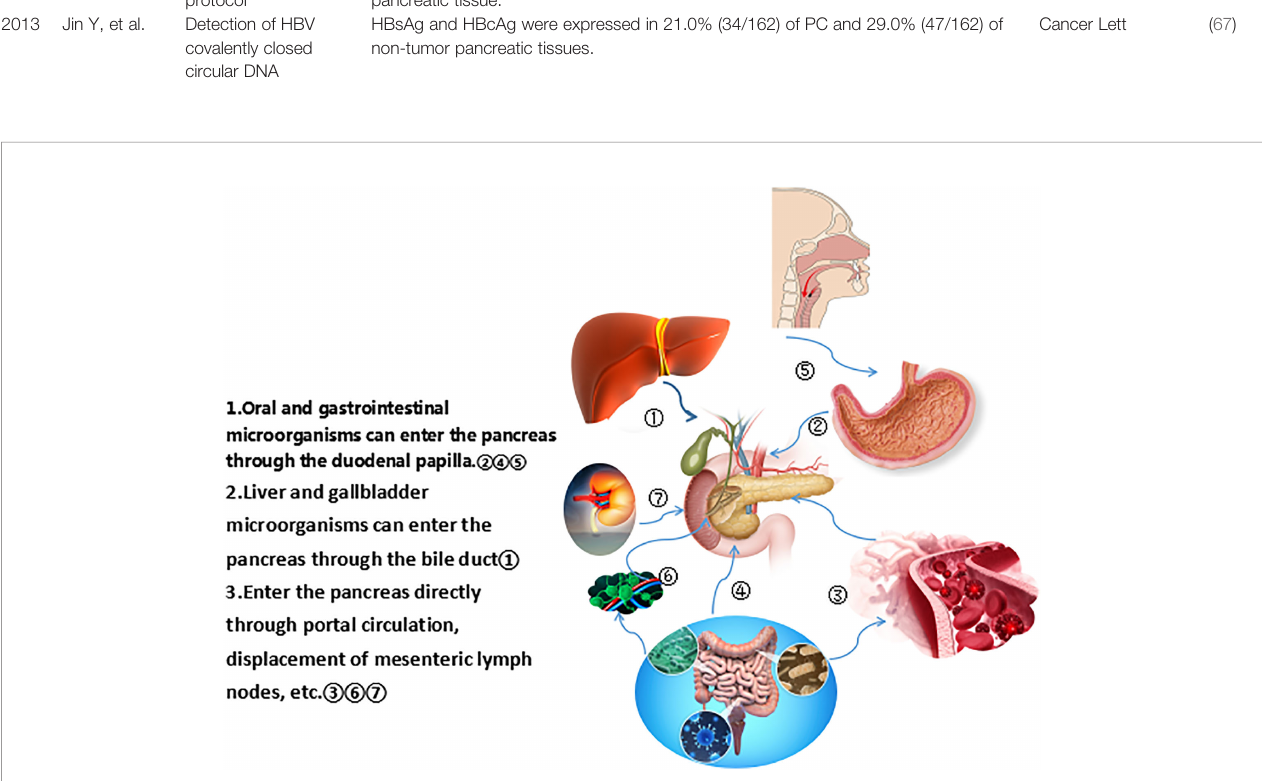
FIGURE 1 | Different ways for microorganisms from different parts to enter the pancreas.